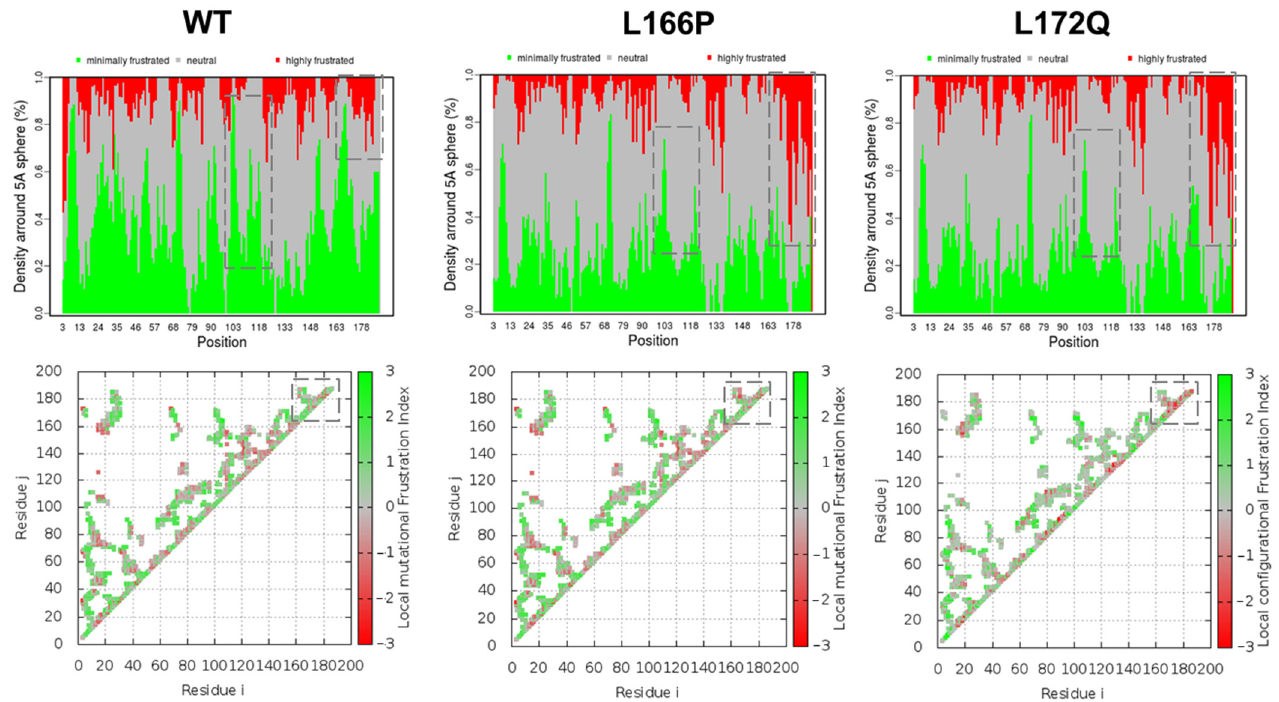
Figure 6. Frustration and configurational loss and gain contacts in WT, L166P, and L172Q, where minimally frustrated (green) and highly frustrated (red) residues are depicted. The upper and lower panels show the density and covariance matrices, respectively.